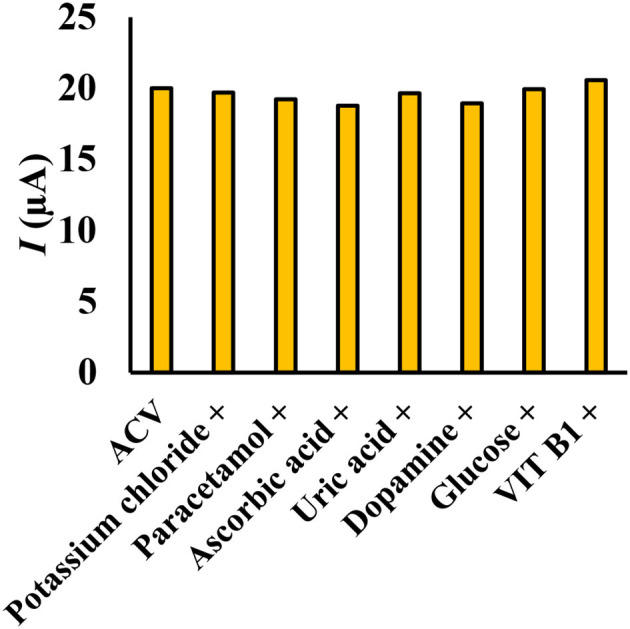
Simultaneous determination of ACV in the presence of some interfering species (ratio >100), the experimental conditions: 0.1 M phosphate buffer, pH = 4, scan rate = 50 mVs−1, ACV concentration = 30 μM.